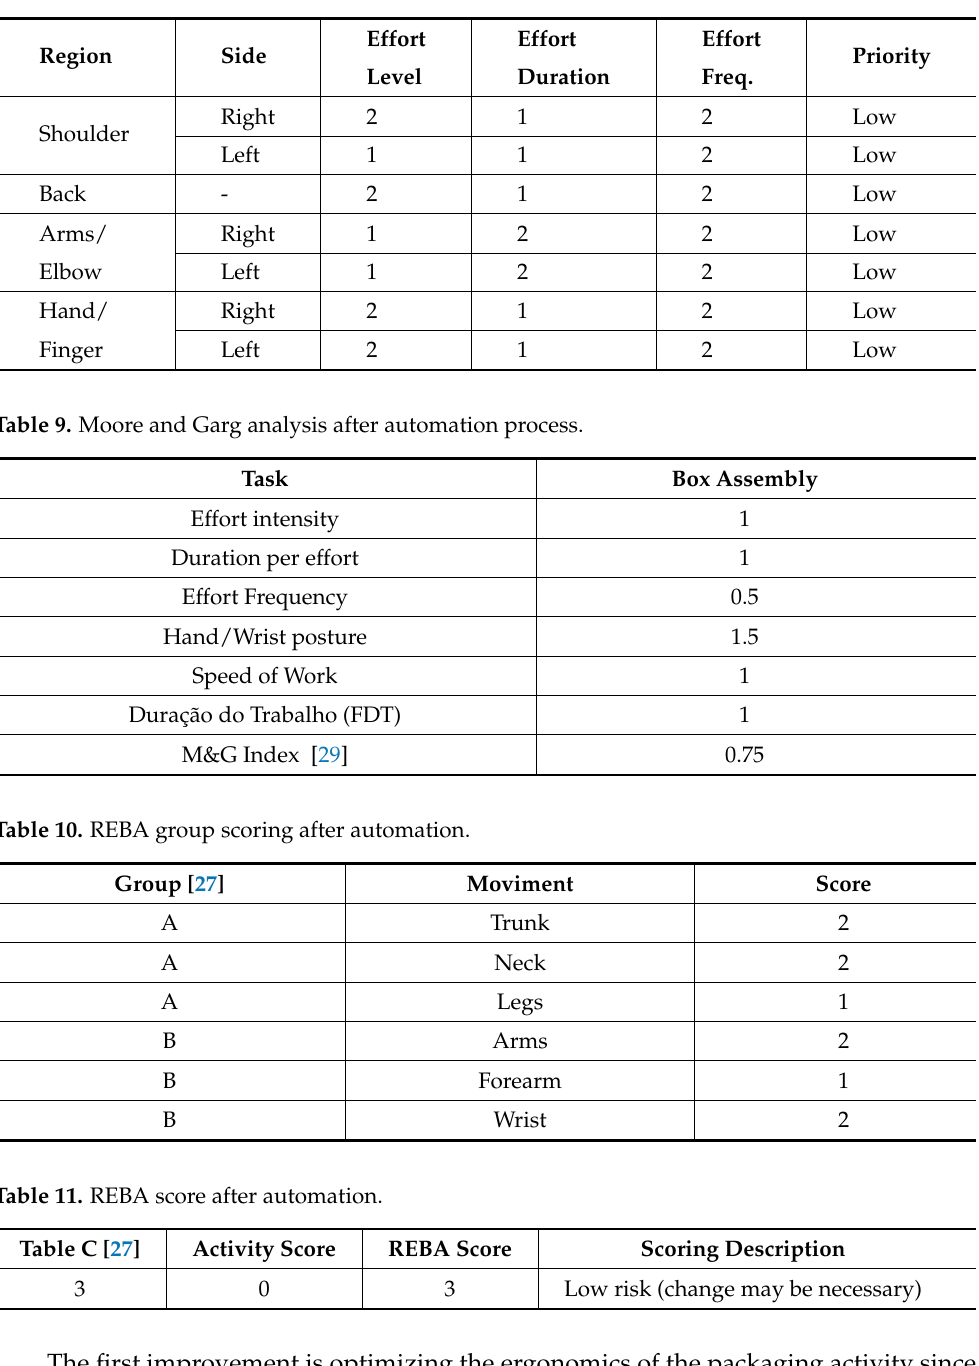
Table 8. Suzanne Rodgers analysis after automation process.